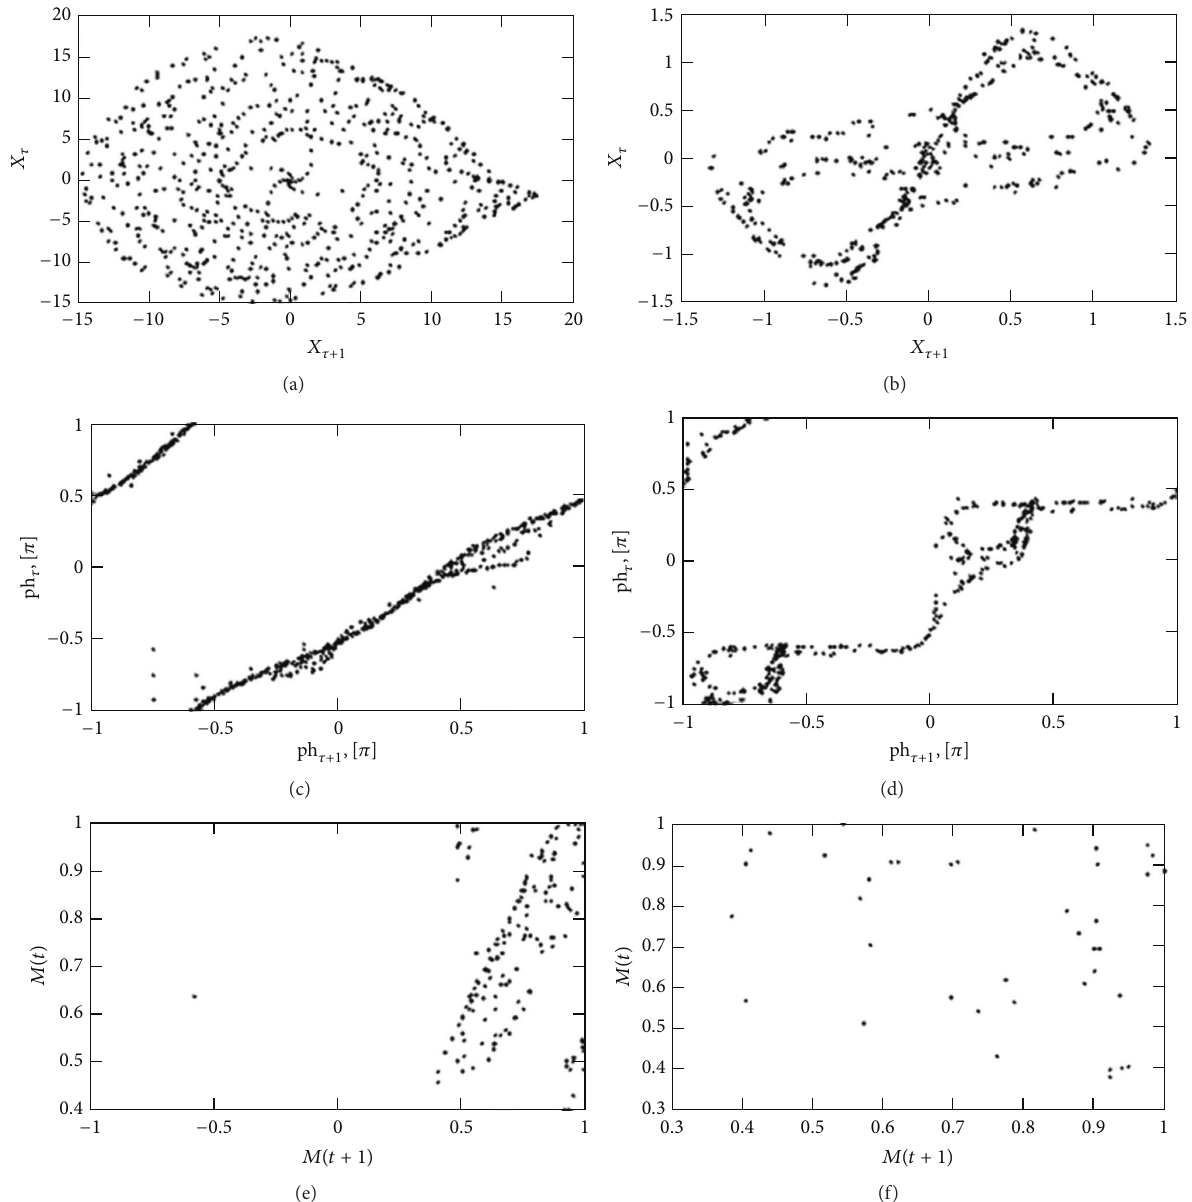
Figure 7: (a) Reconstructed phase portrait ( 𝑥(𝜏 𝑠 ) versus 𝑥(𝜏 𝑠 + 1) ) from the 𝑋 -Rossler coordinate corresponding to 𝜏 𝑠 = 8 ; (b) reconstructed phase portrait ( 𝑥(𝜏 𝑠 ) versus 𝑥(𝜏 𝑠 + 1) ) from the 𝑋 -Lorenz coordinate corresponding to 𝜏 𝑠 = 11 ; (c) angle first-return map obtained with the proposed methodology for the 𝑋 -Rossler coordinate; (d) angle first-return map obtained with the proposed methodology for the 𝑋 -Lorenz coordinate; (e) angular first-return map obtained from the local maxima for the 𝑋 -Rossler coordinate; (f) angular first-return map obtained from the local maxima for the 𝑋 -Lorenz